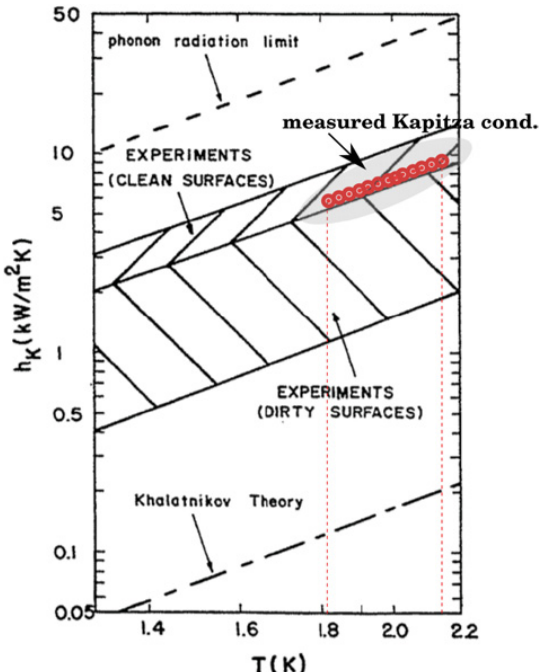
Figure 3. Kapitza conductance between copper and superfluid helium. The conductance is affected by surface cleanliness. The picture is taken from [5] (Fig. 5.22). The filled red circles show the result of our measurement at KEK (this